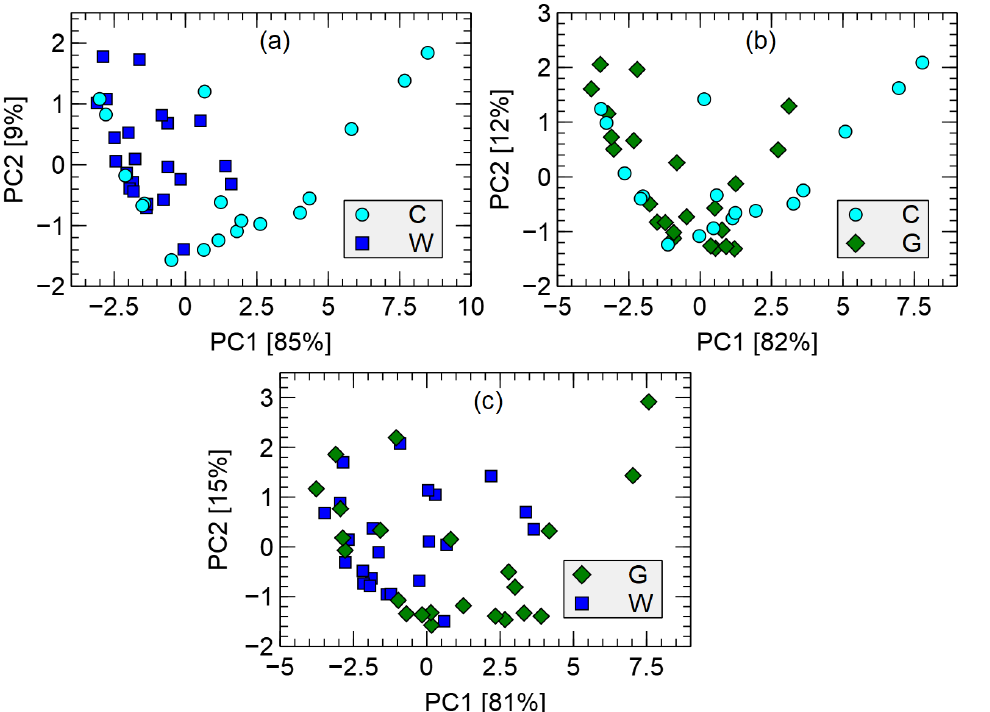
Figure 9. Visualization of measured data in the Principal Component space, transforming the 10 the most important modeling features. Variability captured by the PC is indicated in axis labels. Comparison of C–uninfected, G–green, W–white samples. ( a ) uninfected vs. white, ( b ) uninfected vs. green, ( c ) green vs.